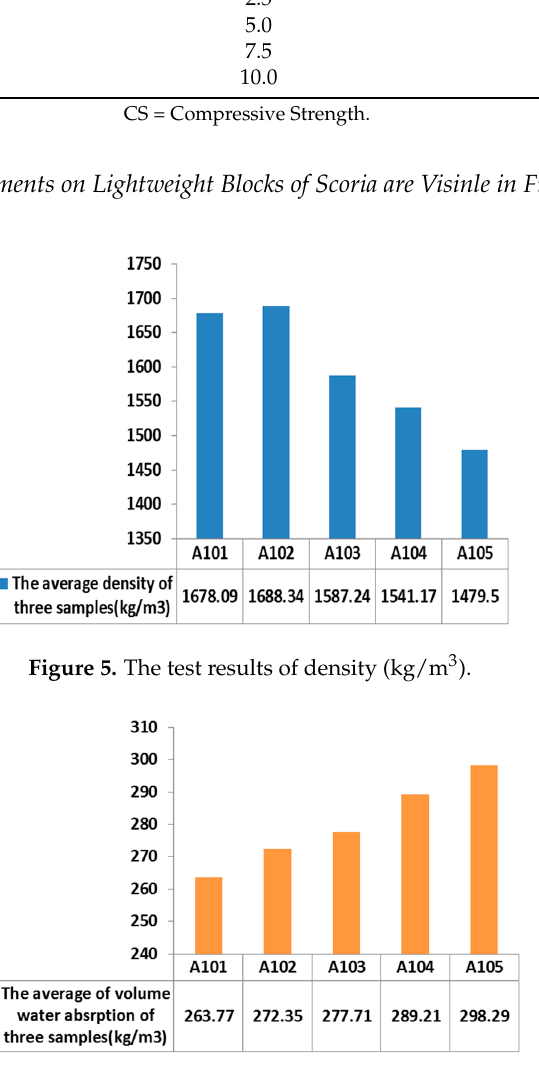
Figure 6. The test results of volume water absorption (kg/m 3 ).